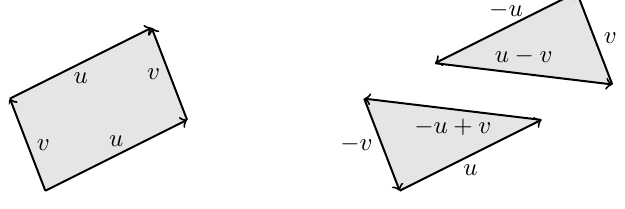
Figure 3: The fundamental domain of the torus seen as the gluing of two euclidean triangles by transla-